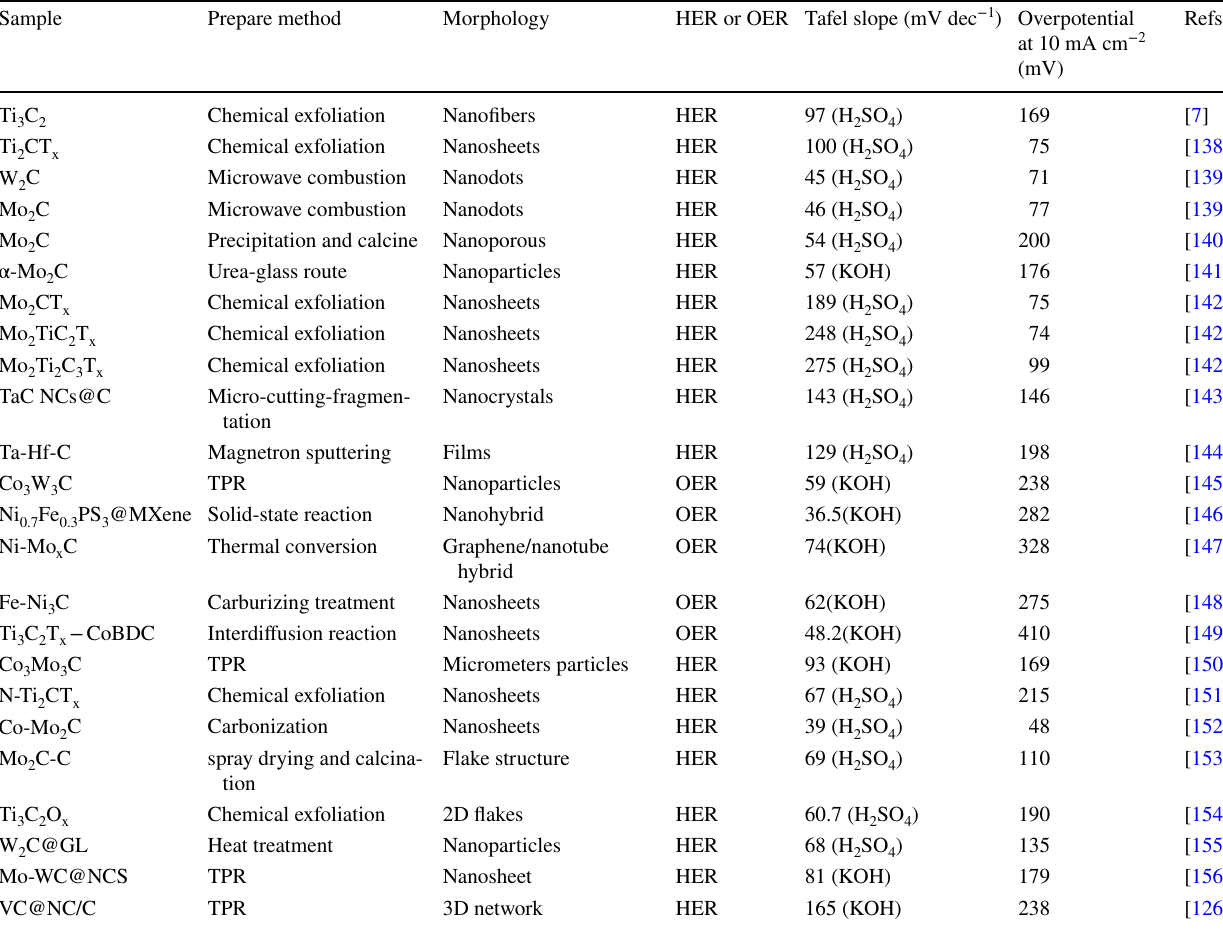
Table 3 Electrocatalytic performance of transition metal carbides